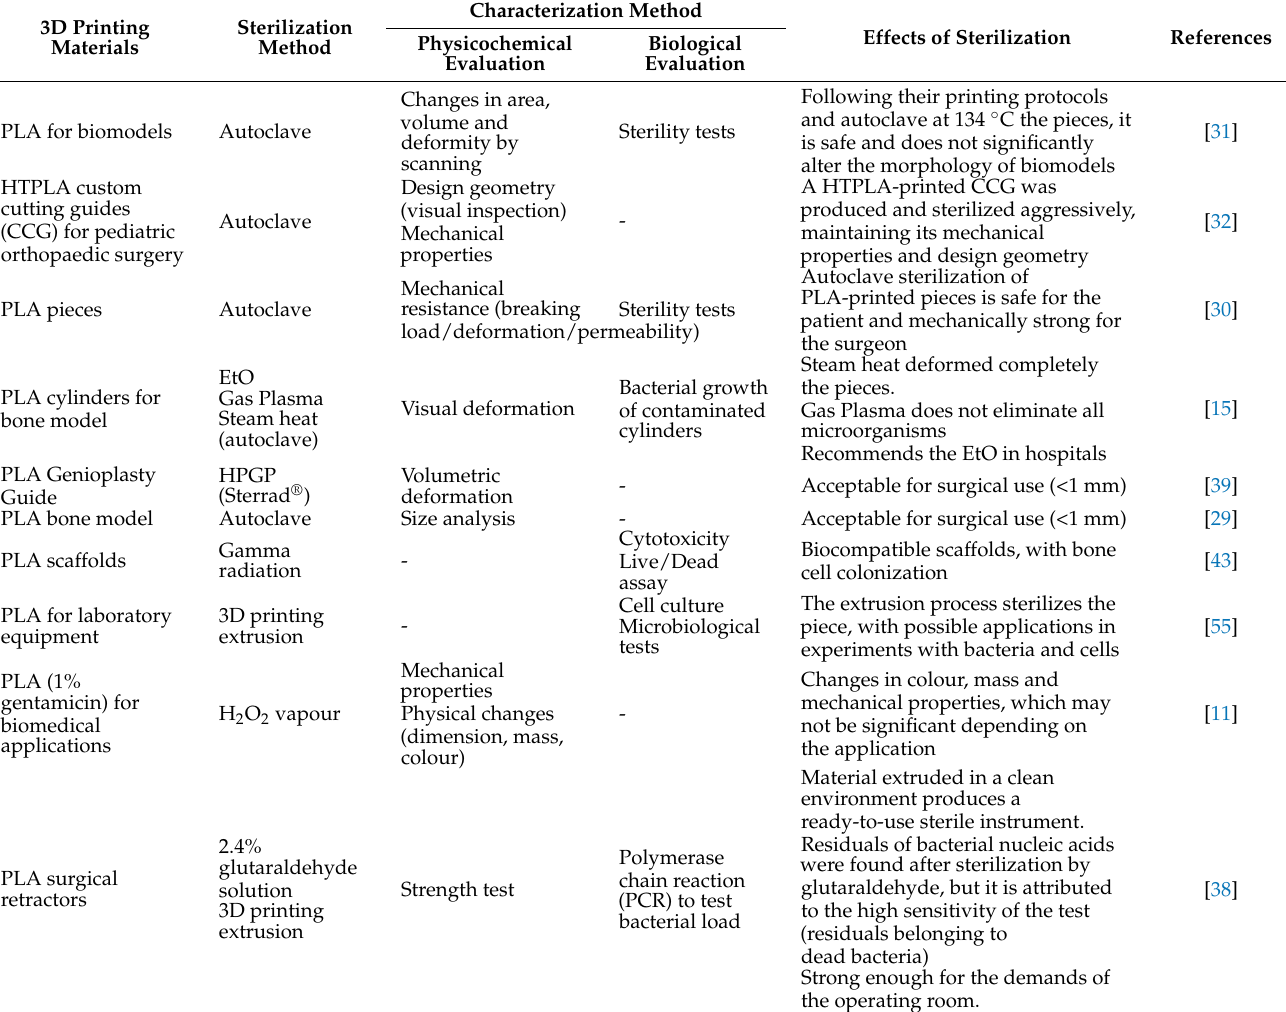
Table 3. Summary of the published papers related to the sterilization of 3D printing of PLA for biomedical